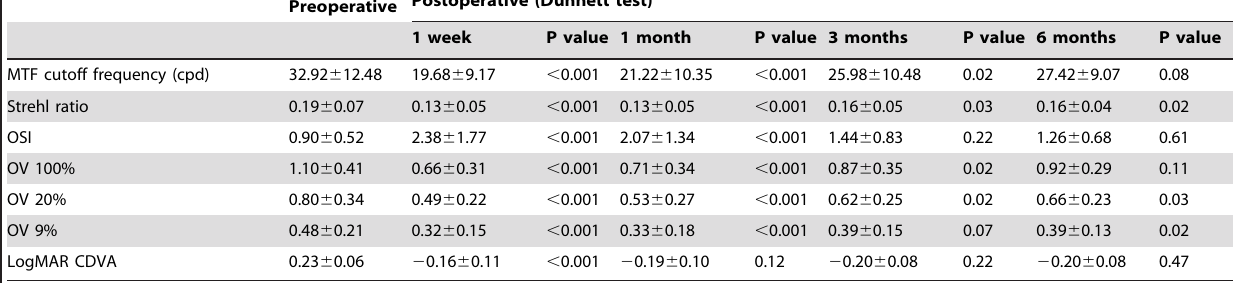
Table 2. Time course of the detailed optical parameters of the